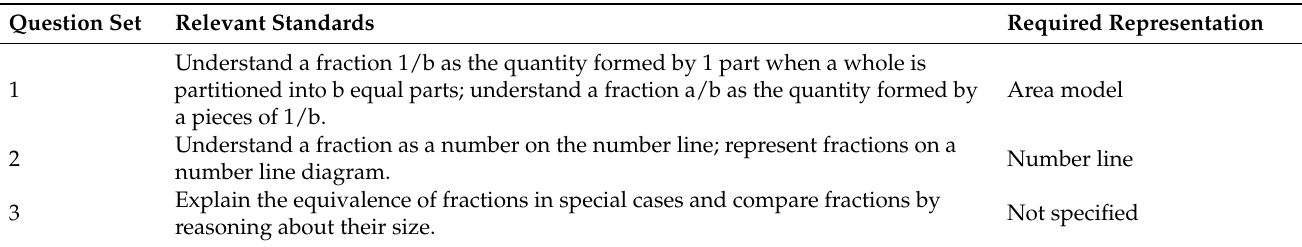
Table 1. Required components and target standards for each question